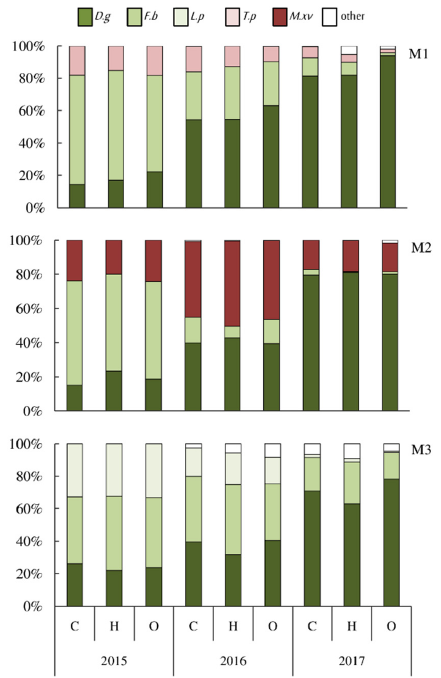
Figure 1. Botanical composition of the sward of grass–legume mixtures (M1— D. glomerata , F. braunii , T. pratense ; M2— D. glomerata , F. braunii , M.x varia ) and grass mixture (M3— D. glomerata , F. braunii , L. perenne ) in the first cut depending on the silicon fertilization (C—control, H—Herbagreen, O—Optysil) during 3-years of utilization. D.g — D. glomerata , F.b — F. braunii , L.p — L. perenne , T.p — T. pratense , M. xv — M.x varia